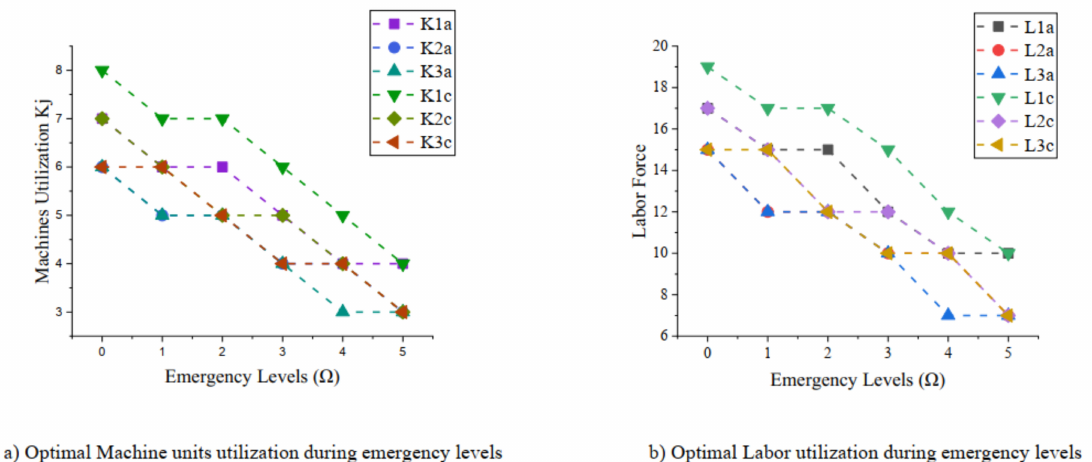
Figure 2. The optimal utilization of the resources in pandemic conditions: ( a ) Machines utilization ( b ) Labor force required.